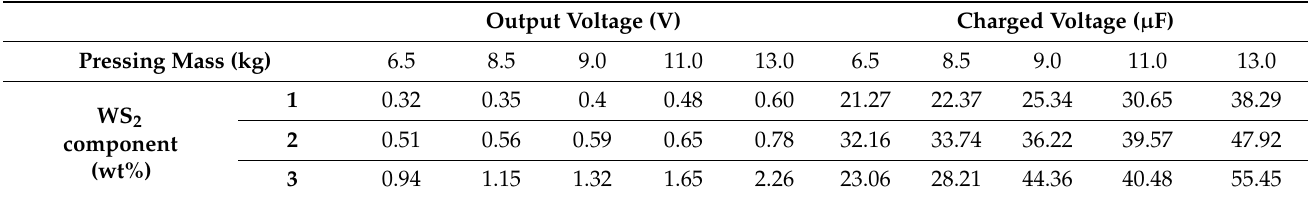
Table 2. Summary of the various output performances under various pressing mass conditions and WS 2 components.